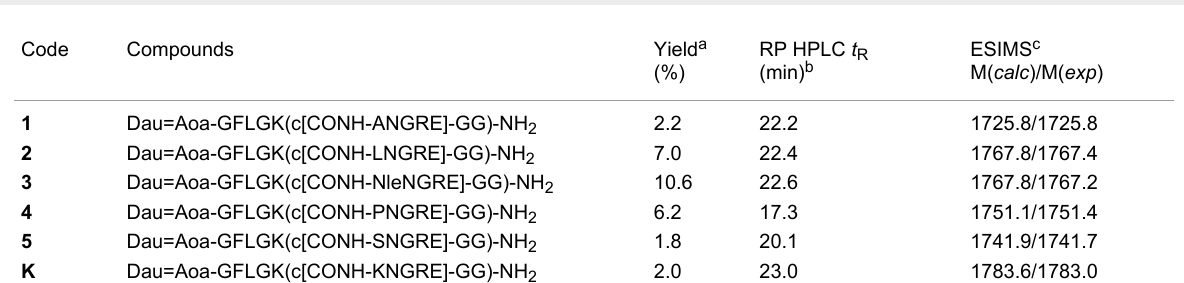
Table 1: List of the peptide drug-conjugates